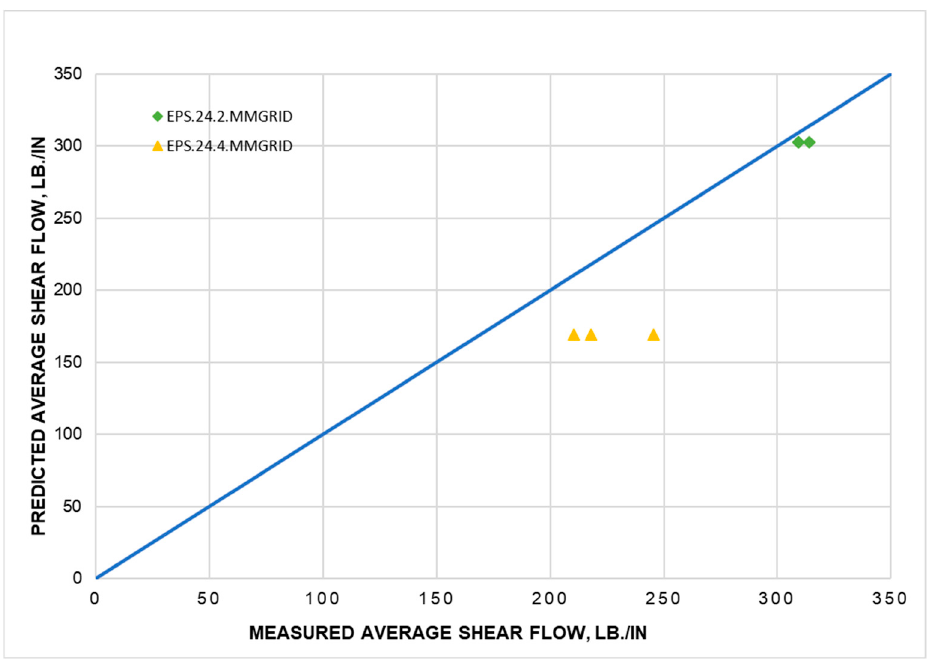
Figure 24. Predicted values from the ICC-ES AC422 equation [22] based on a 99.7% confidence interval vs. measured average shear flow (1 lb/in = 0.2 N/mm).